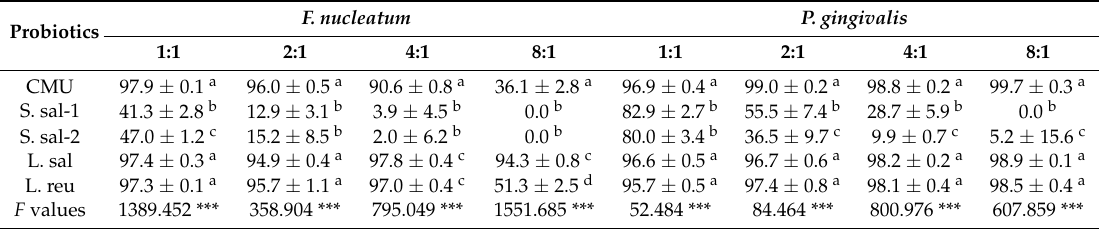
Table 3. Dose-dependent effects of oral probiotic culture supernatants on the growth of cariogenic bacteria, F. nucleatum and P. gingivalis , expressed as inhibition level (%). F. nucleatum Probiotics